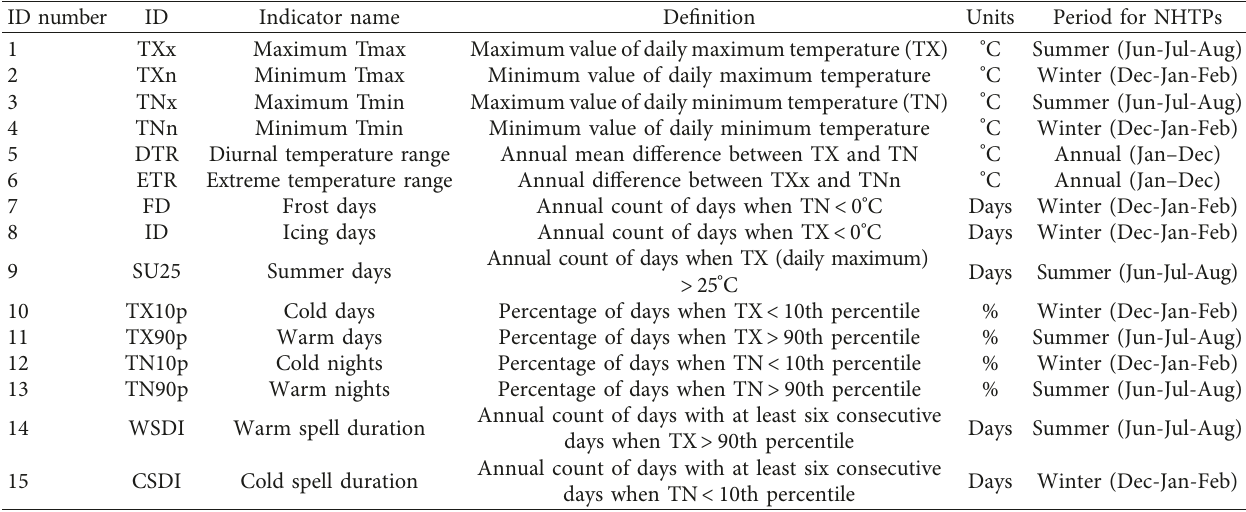
Table 1: Definitions of selected daily extreme temperature indices and their period of Northern Hemisphere teleconnection patterns (NHTPs) for this study.